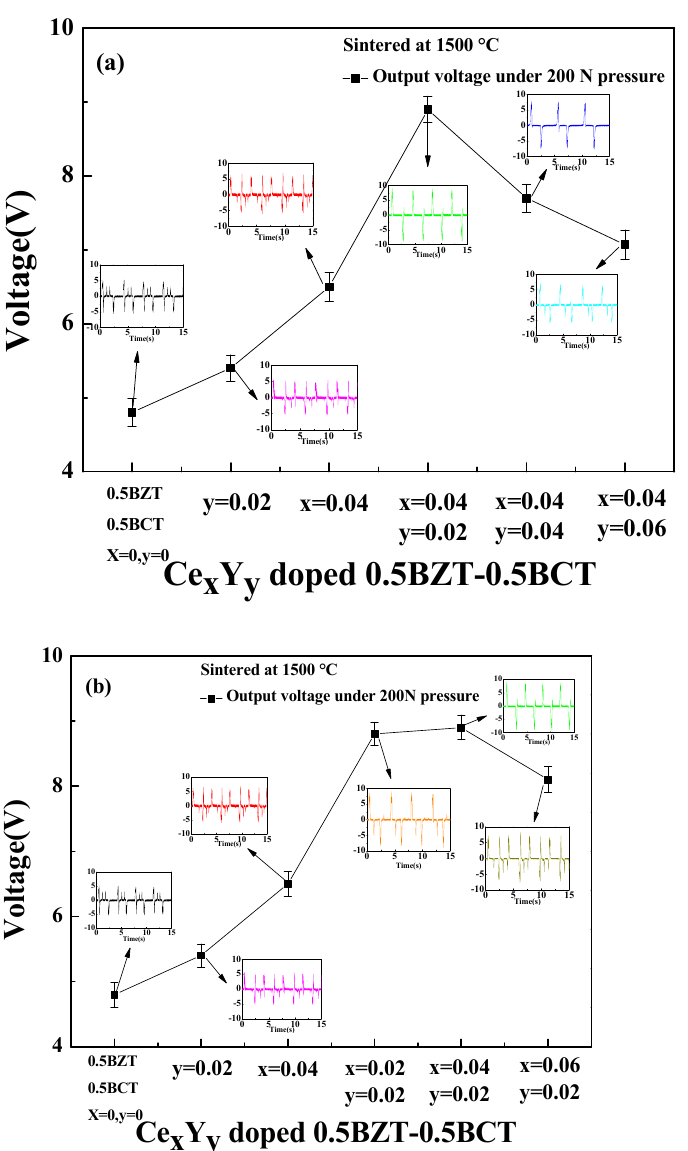
Figure 8. Generated output voltage in the BCZT-CY ceramics ceramic after applying a pressure of 200 N. ( a ) For the Ce 0.04 Y y doped BCZT ceramics, ( b ) Ce x Y 0.02 doped BCZT ceramics, respectively.